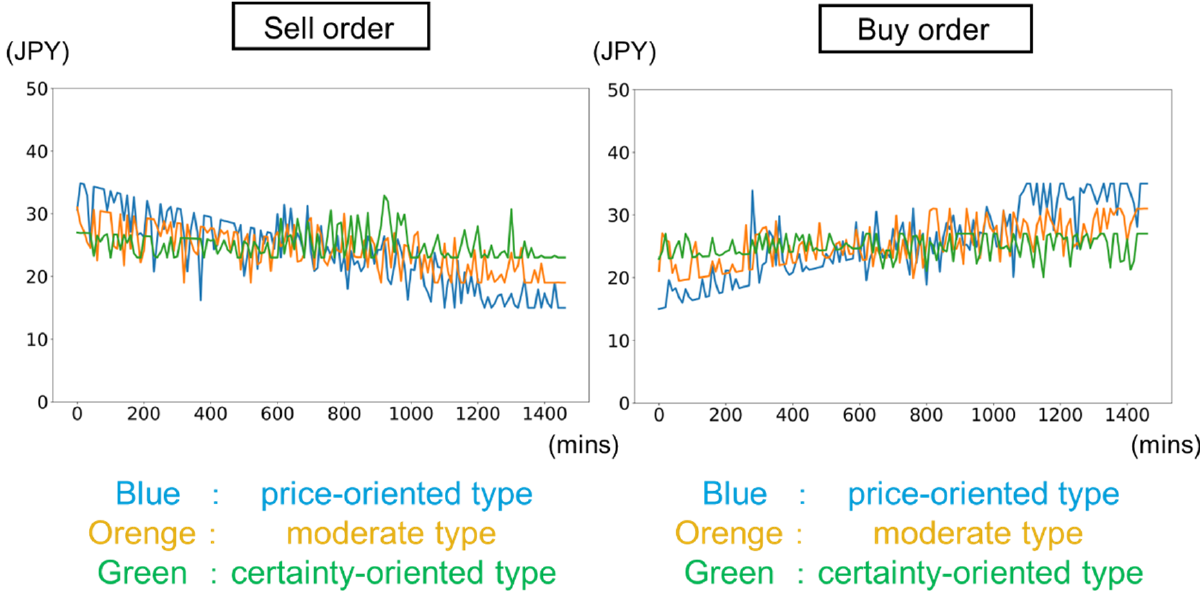
Figure A2. Actual bidding price (price with a random term).